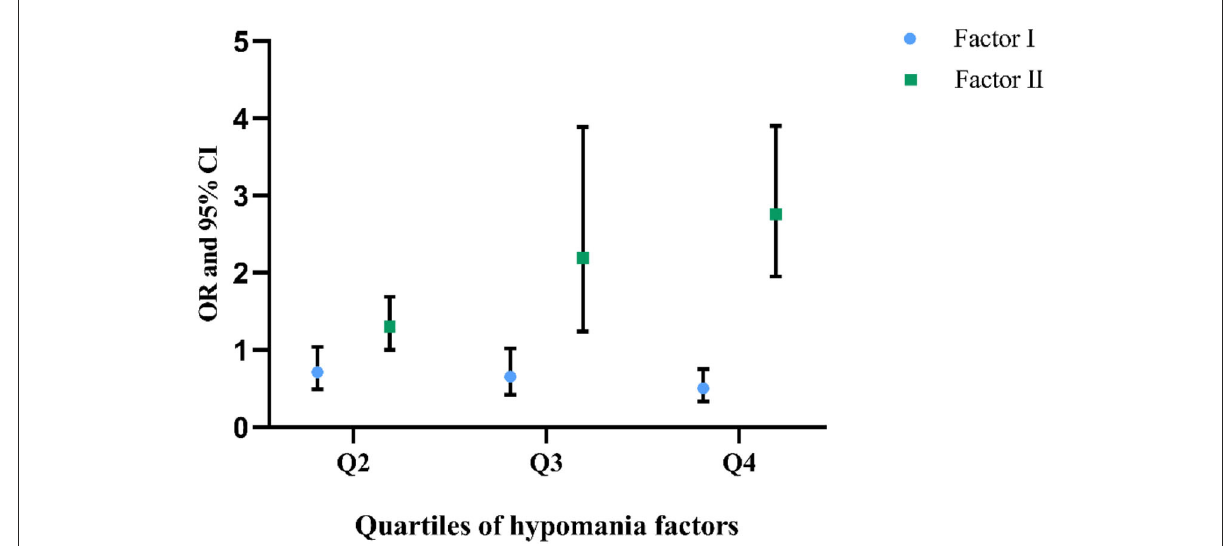
FIGURE2 Quartiles of hypomania factors with SH prevalence (reference: Q1).